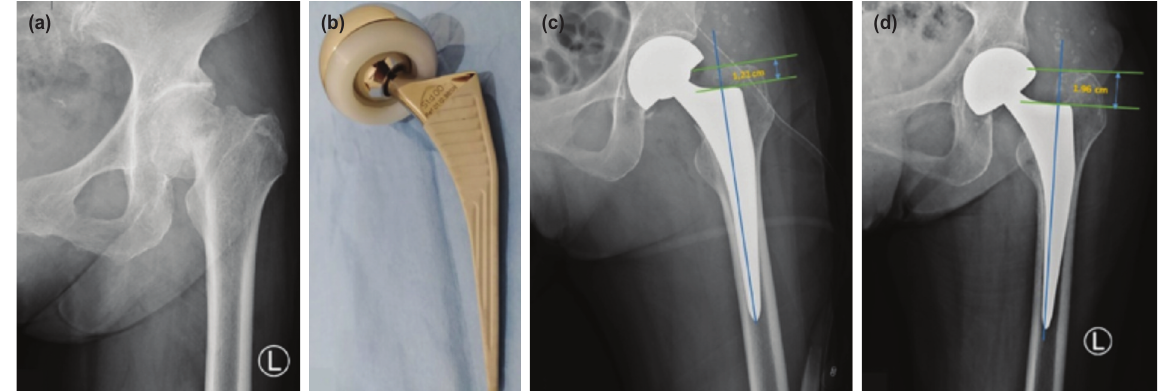
(a) Example of measured femoral stem subsidence in a female, 79 years old. Pre-operative radiograph. (b) Implants that was used Fig. 4: in this study. (c) Post-operative radiograph. (d) Radiograph taken during follow-up (three